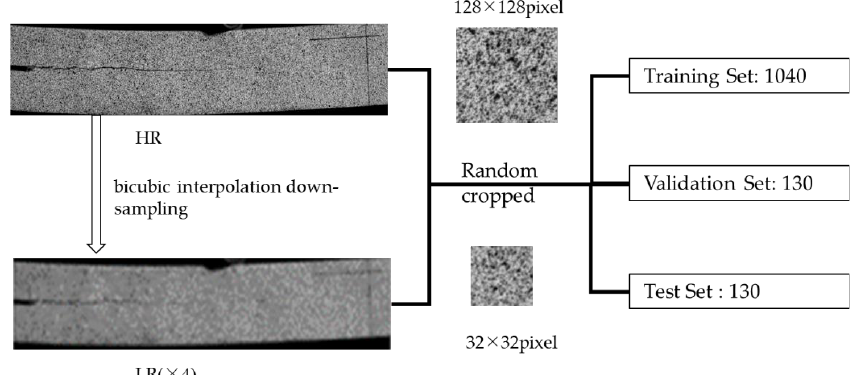
Figure 3. Production and distribution of datasets.